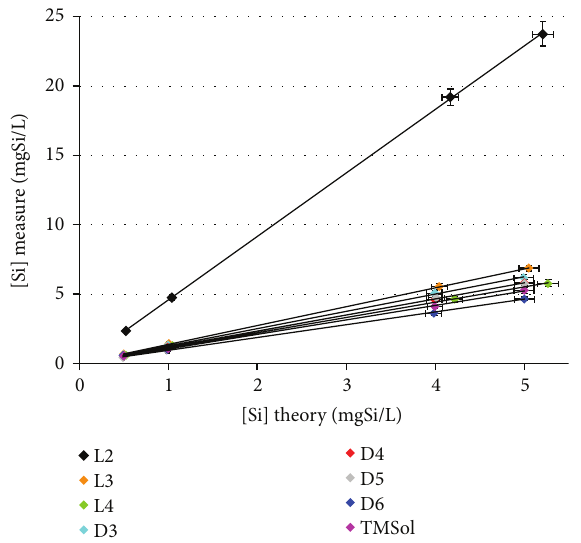
Figure 3: VOSiCs ICP-OES analytical responses (L5 calibration curve) by comparison with the theoretical concentration. Analyses are performed at − 10 ∘ C and each value is the mean of 3 measure- ments.